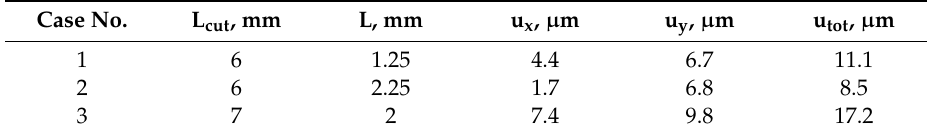
Table 3. List of the most suitable values of design variables.